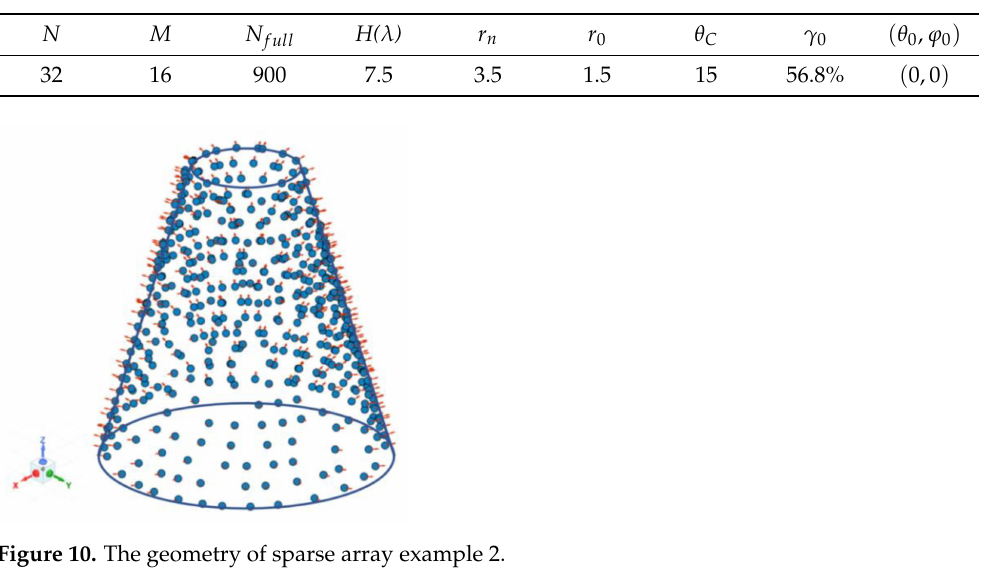
Table 5. The Parameters of the Example Array 2.